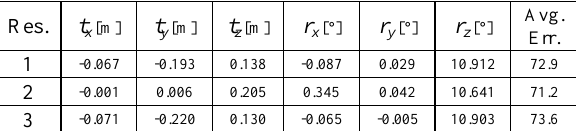
Table 3: Transformation parameters computed with Geomagic Res.